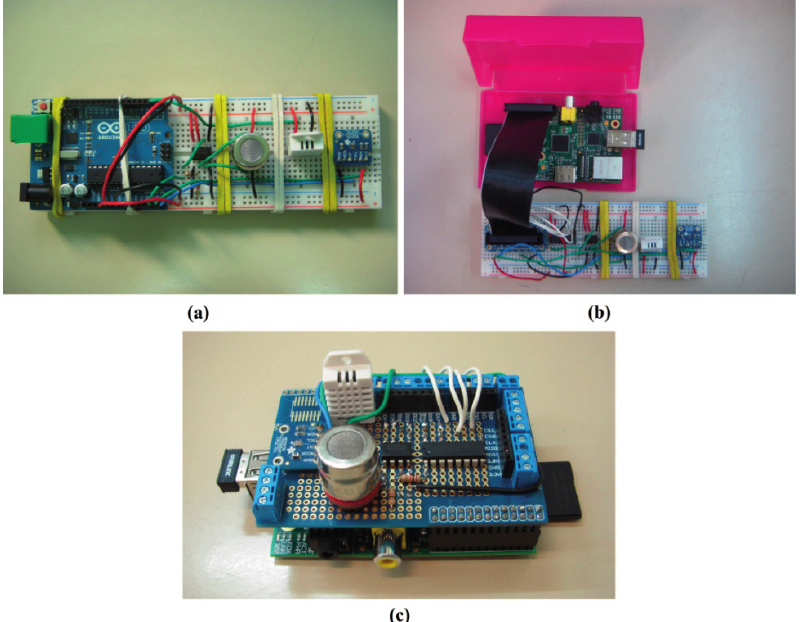
Figure 2. ( a ) Arduino UNO preliminary prototype; ( b ) Raspberry Pi preliminary prototype; ( c ) Raspberry Pi final